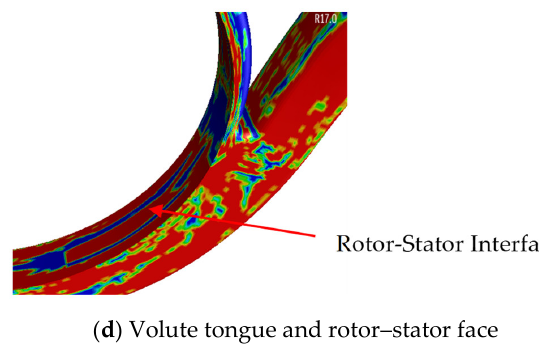
Figure 13. Cloud of mean bubble diameter distribution in the pump flow passage.